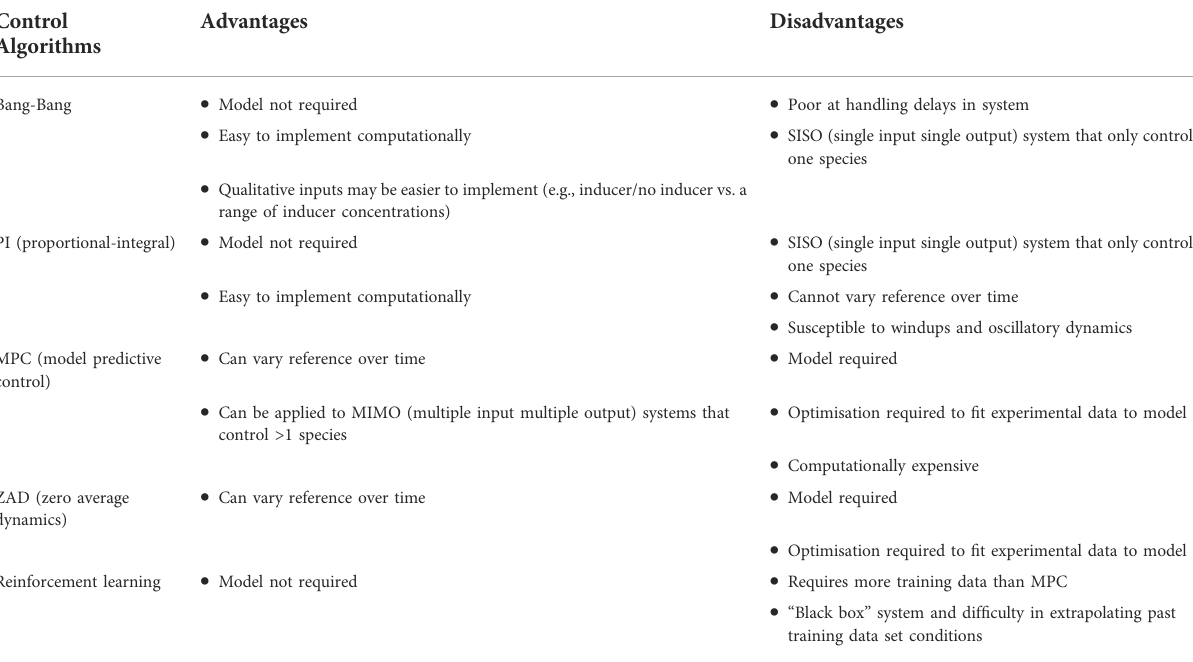
TABLE 2 Control algorithms that can be used for cybergenetic control and their respective advantages/disadvantages. Control Advantages Algorithms